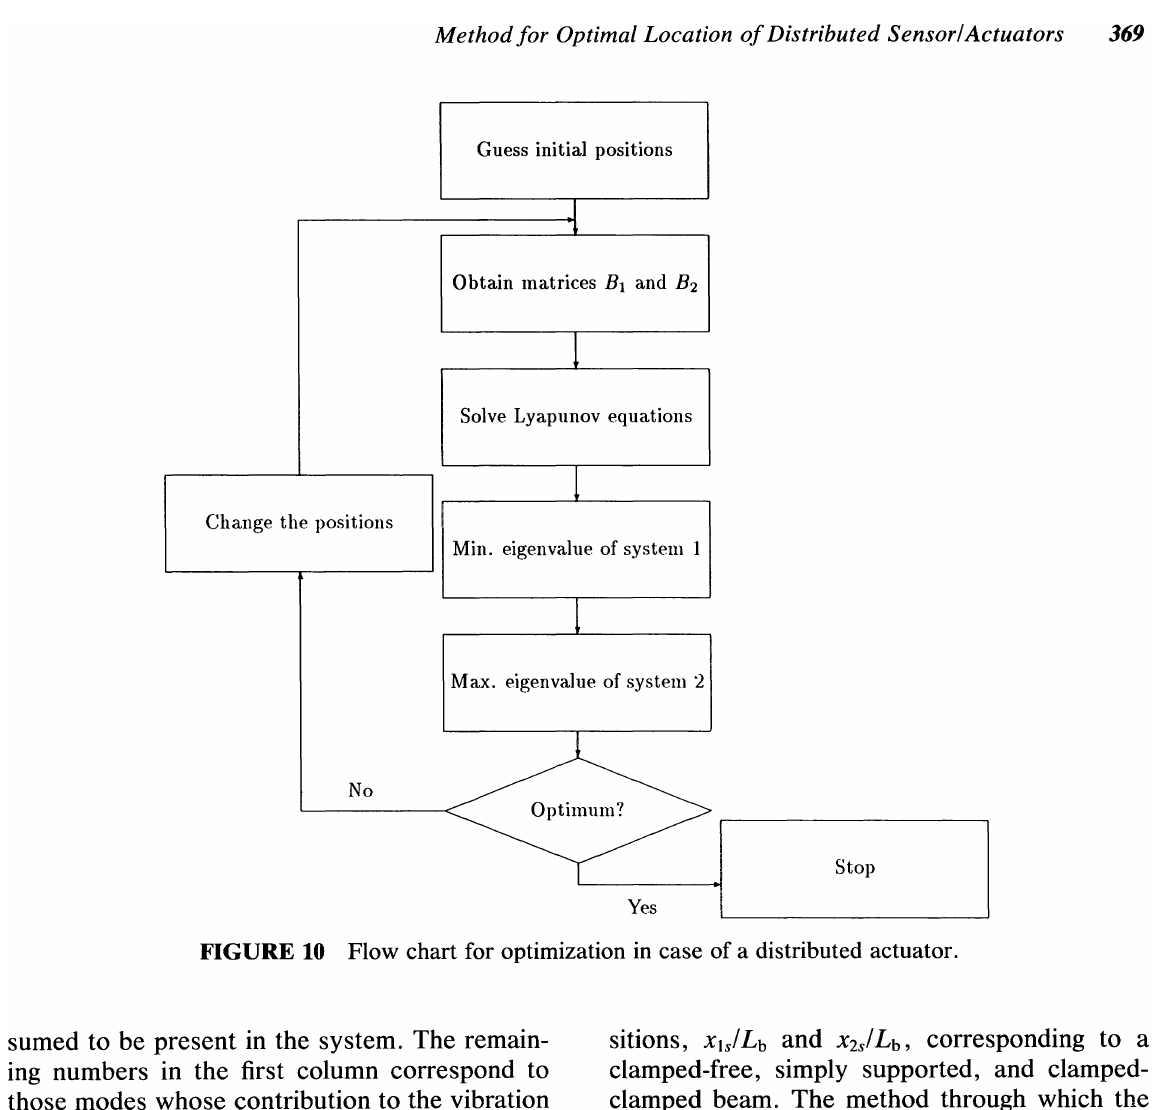
FIGURE 10 Flow chart for optimization in case of a distributed actuator.